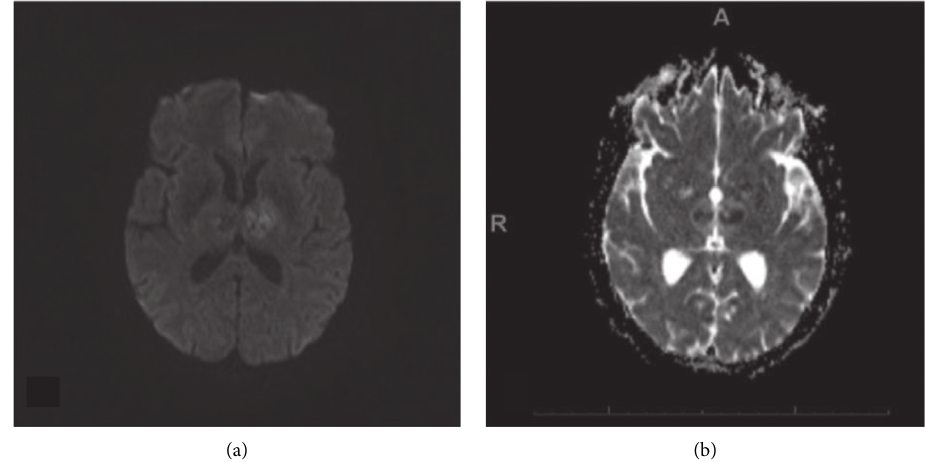
Figure 4: Axial DWI (a) and axial ADC (b) demonstrate subacute ischemic infarct bilaterally in the thalamus with restricted diffusion and low ADC